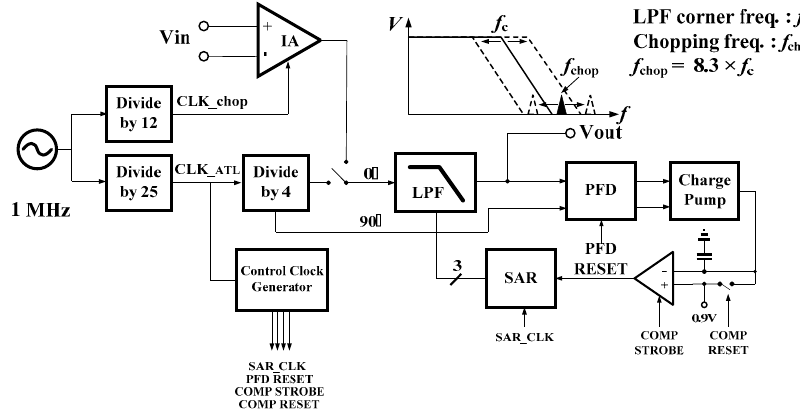
Figure 1. Block diagram of the proposed chopper IA with automatic frequency tuning loop (ATL).